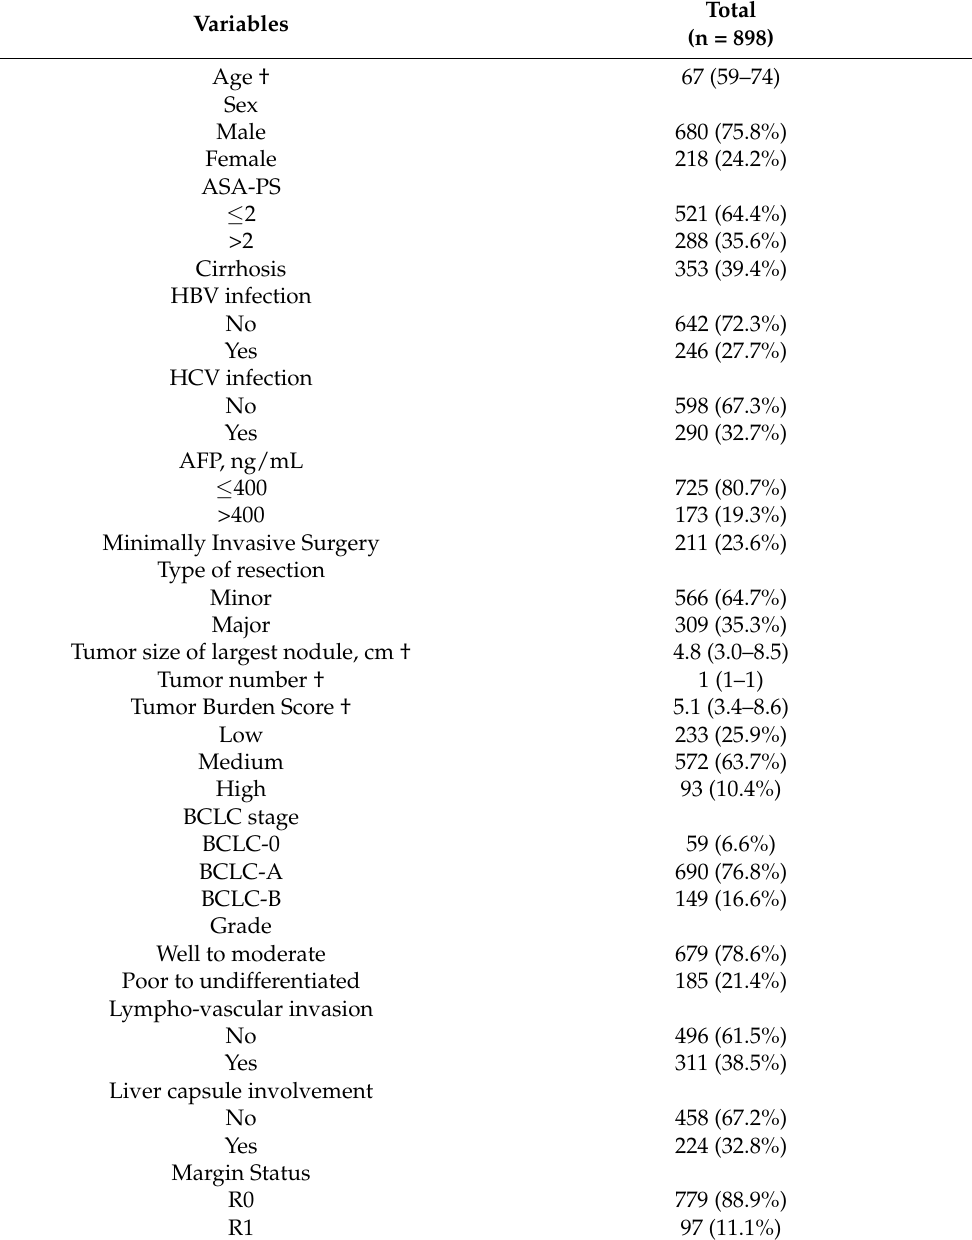
Table 1. Clinicopathologic characteristic of the entire